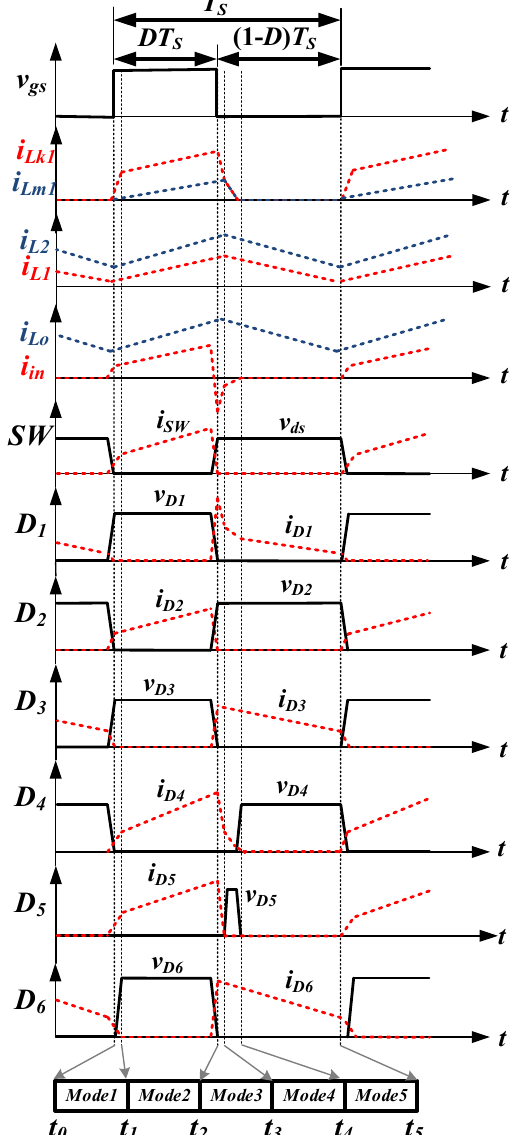
Figure 5. Conceptual key waveforms of the converter in the CCM situation.